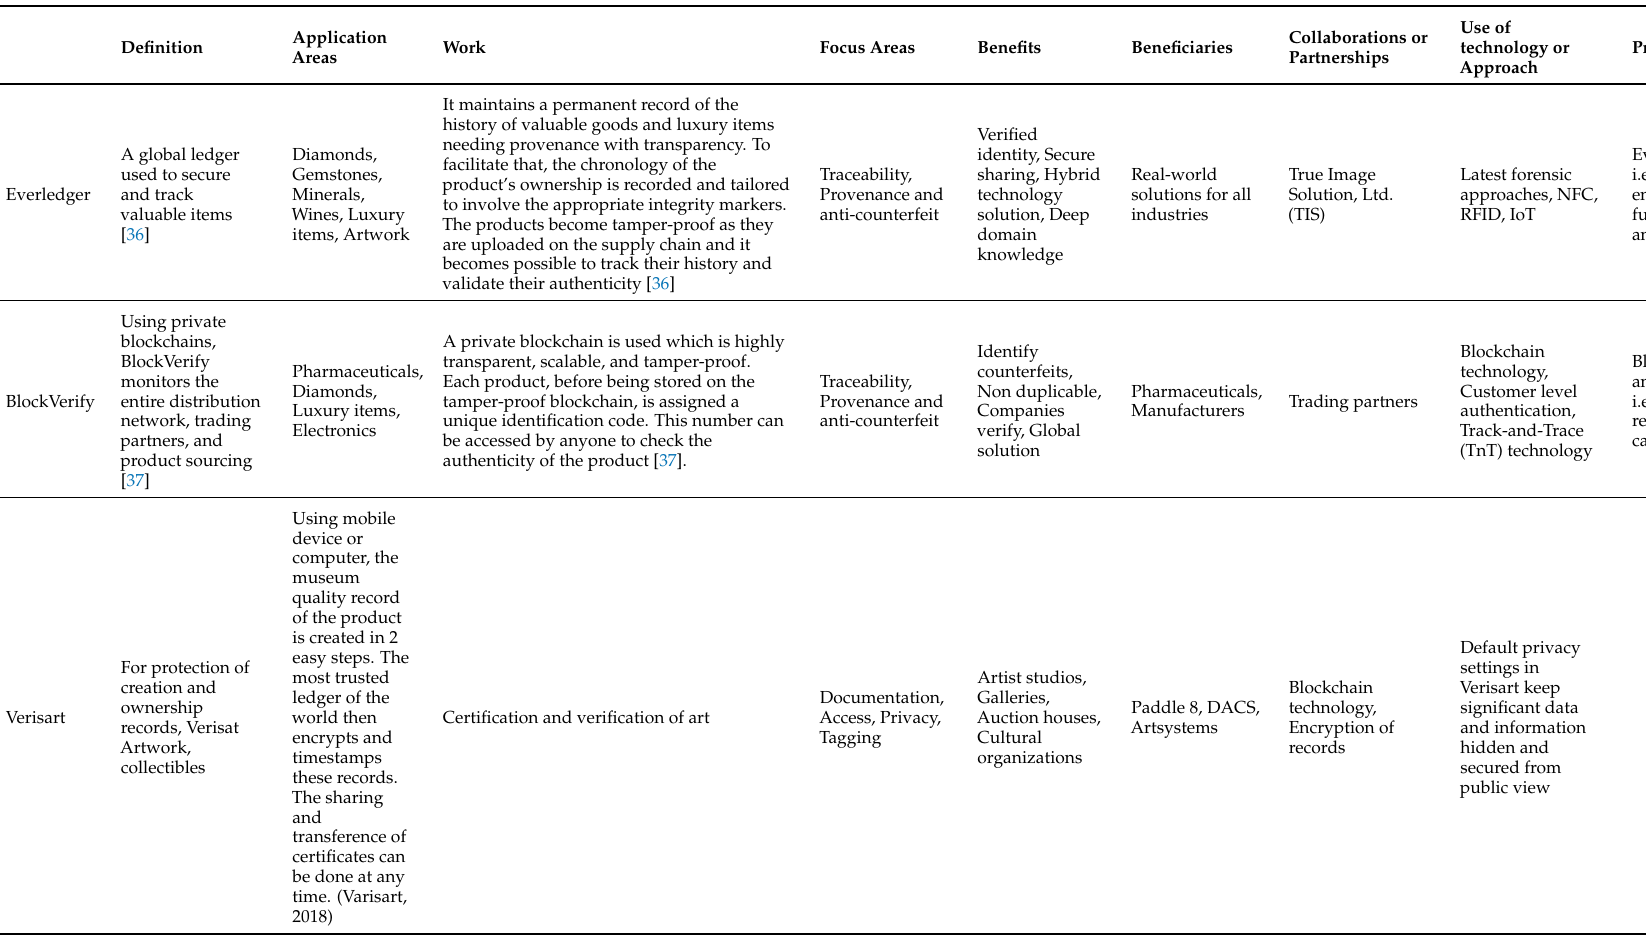
Table A1. Overview of the various supply chain process